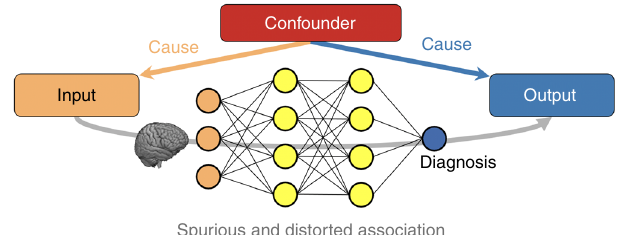
Fig. 1 Confounding effects in deep-learning models. A confounder is a variable that in fl uences both the input and the output of a study causing spurious association, if not properly controlled